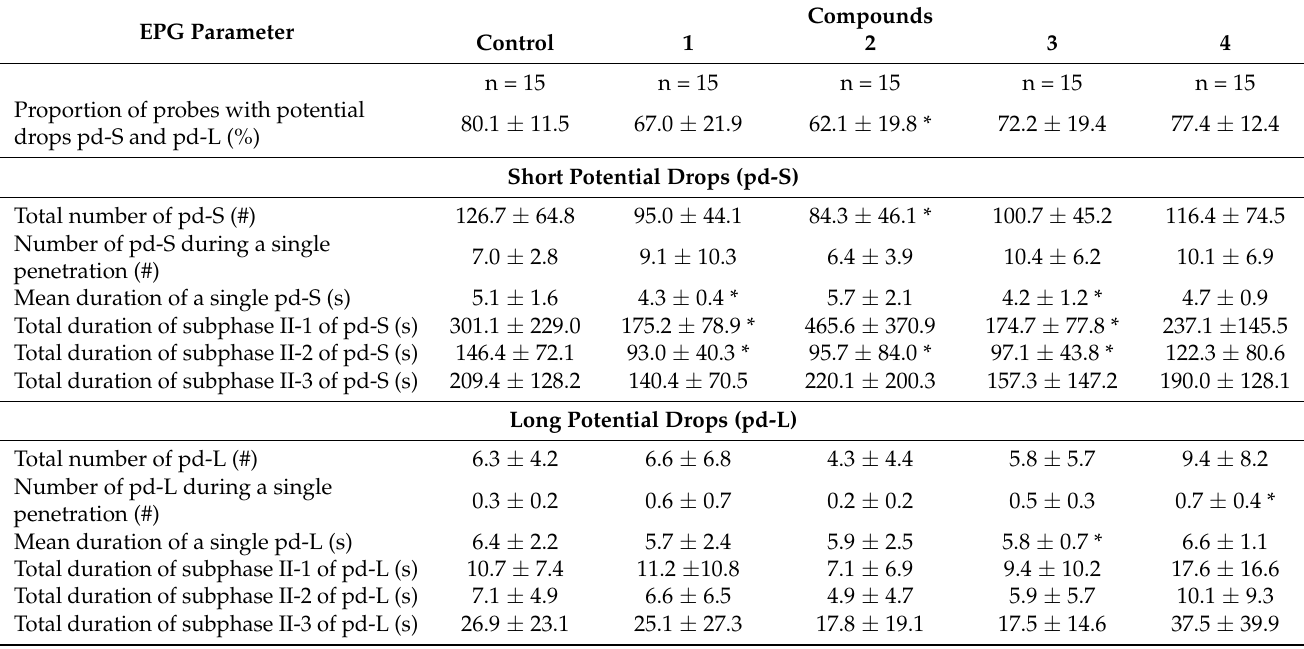
Table 3. Exploratory cell punctures made by Myzus persicae in in non-phloem leaf tissues of